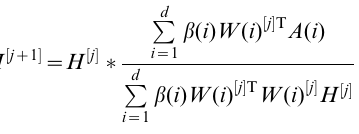
for some small positive matrices g ½ j (cid:2)